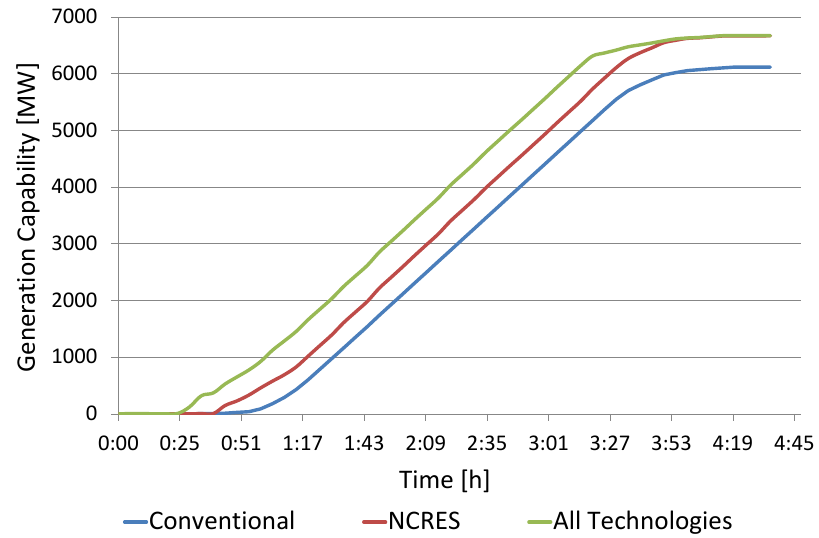
Figure 8. Generation available in the system for all scenarios.